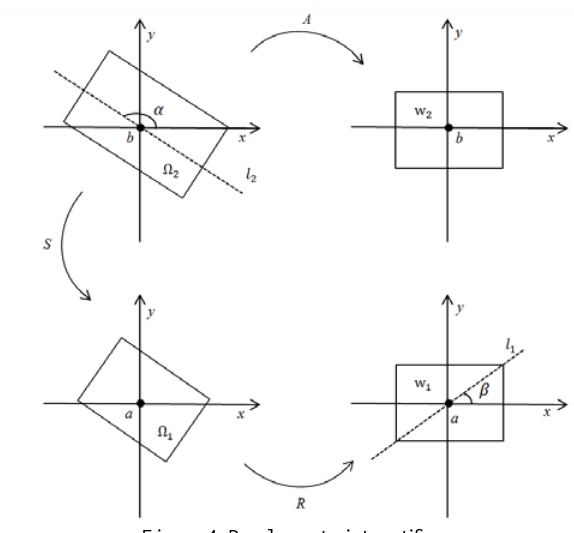
Figure 4. Dual constraint